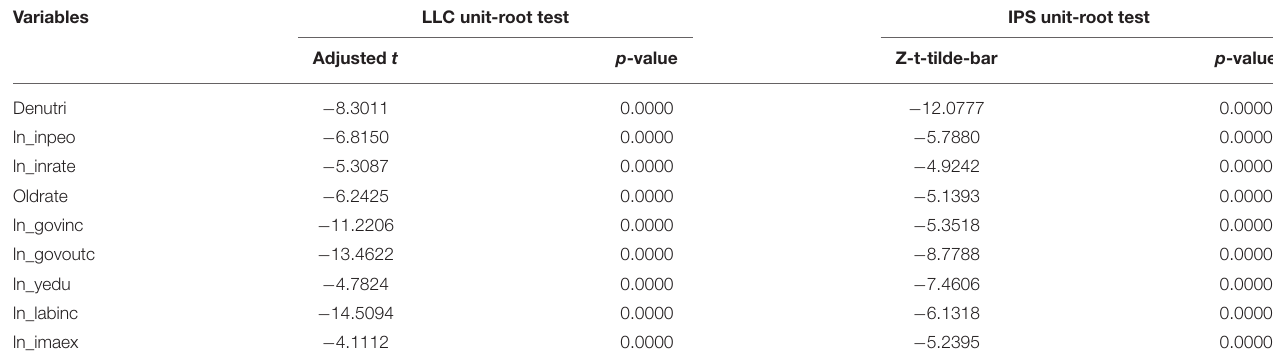
TABLE 2 | Panel unit root